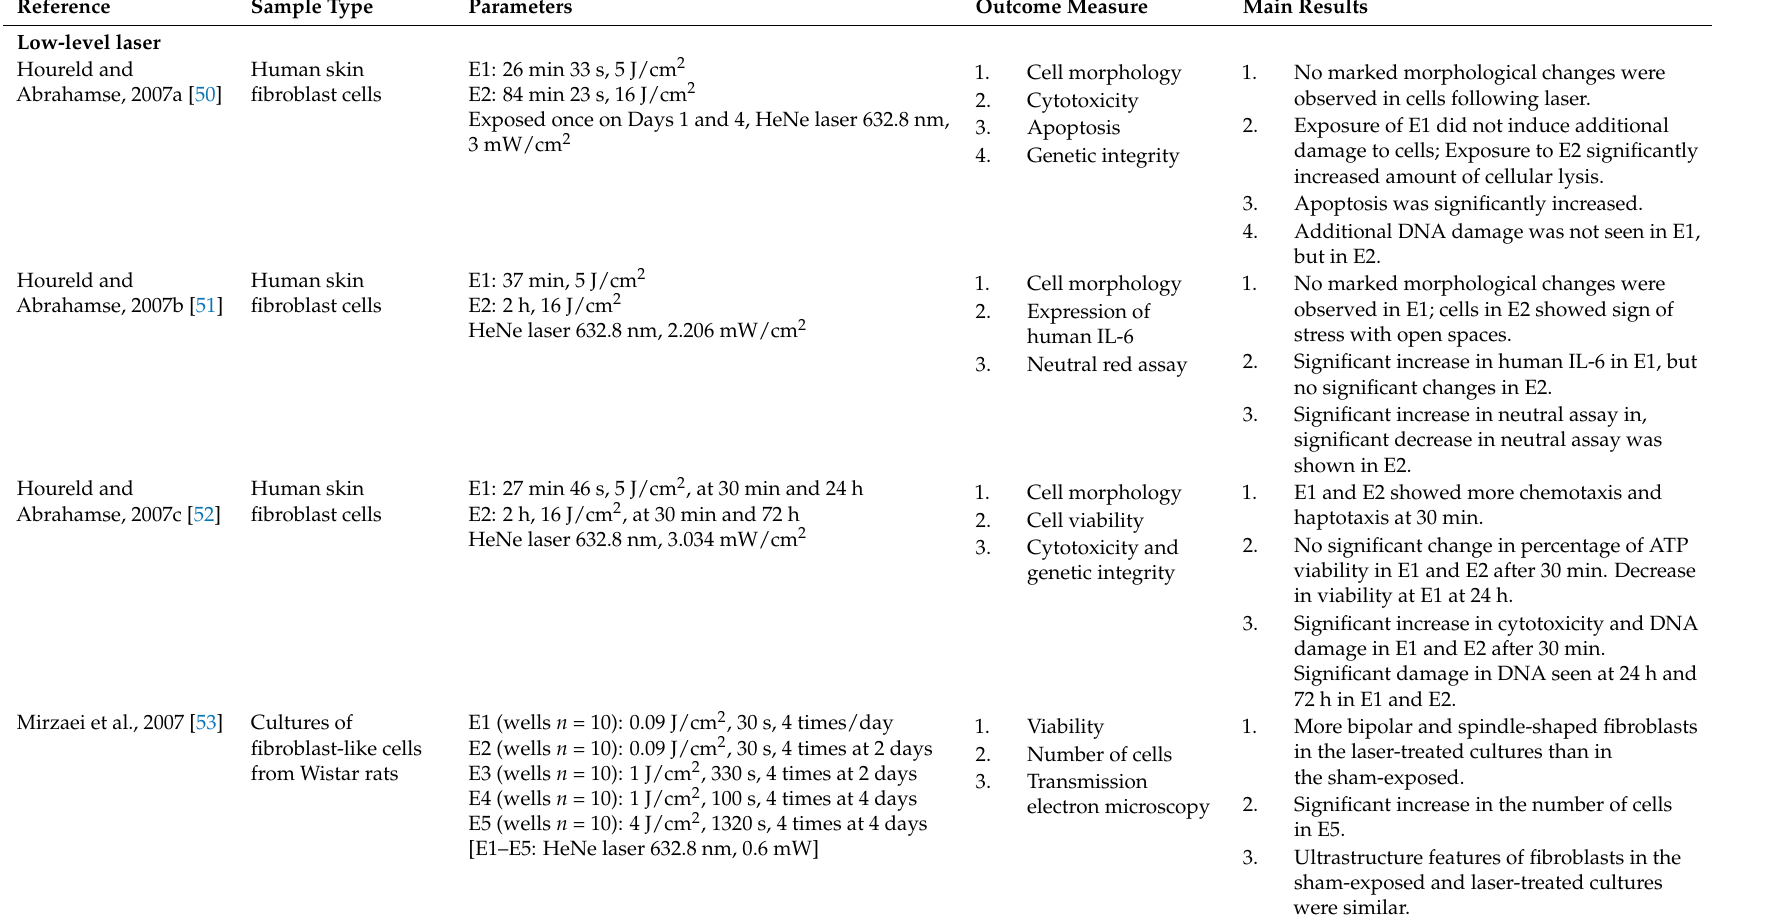
Table 6. Outcomes of in vitro studies on photo energies for treating diabetic